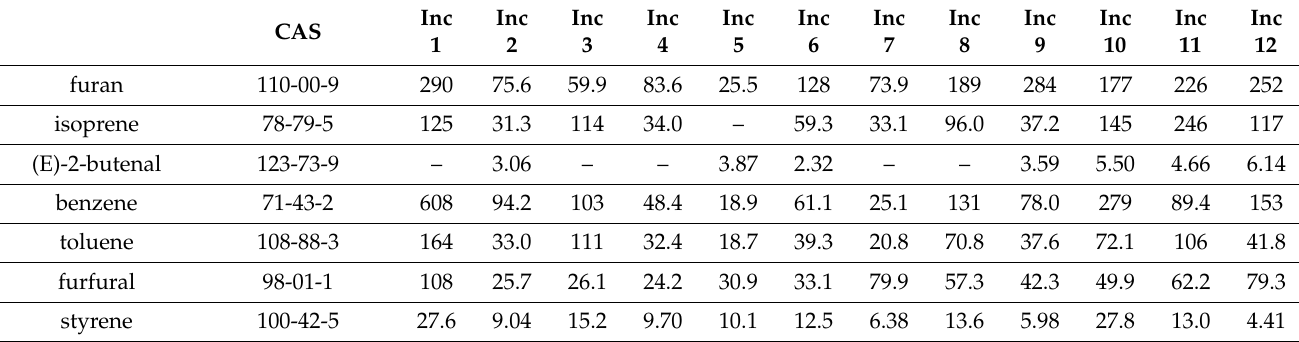
Table 5. Average STPC values (short-term peak concentration) ( µ g/m 3 ) for TVOC, VOCs, and VVOCs selected in this study in the test chamber for the twelve products